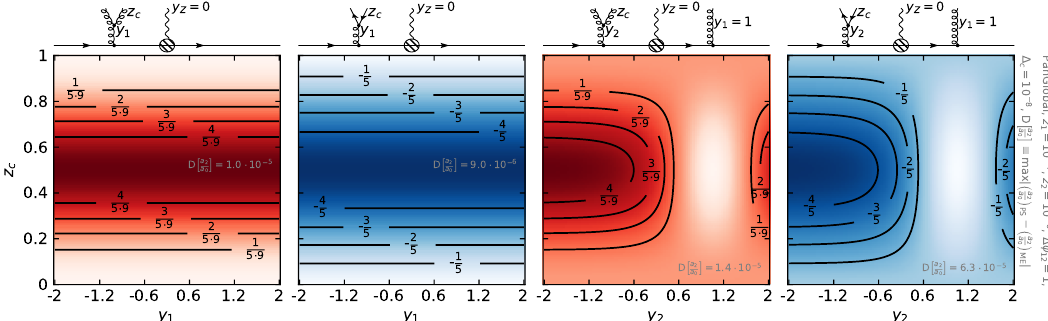
Figure 13. Size of the spin correlations for sequences that involve both soft and collinear split- tings, showing a at O ( α 2 ) (two left-hand plots) and O ( α 3 ) (two right-hand plots). The Feynman 2 /a 0 s s diagrams indicate the sequence of splittings under consideration for all cases. We consider the az- imuthal difference between the plane defined by the primary soft splitting with momentum fraction z 1 ( z 2 ), and the plane defined by the second (third) splitting with momentum fraction z c . The colour indicates the size of a as predicted by the shower. Black lines indicate constant values 2 /a 0 for this ratio, and are obtained by using crossing relations in the matrix elements calculated in ref. [45] for final-state